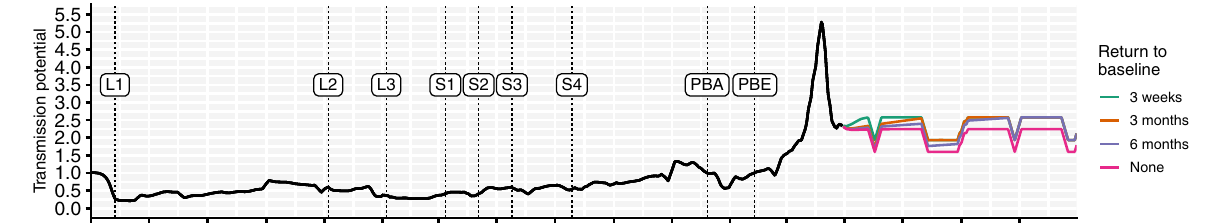
December2021andtheendingofthesemeasureson27thJanuary2022 67 .Middle: Fitted transmission adjustments between April 2020 and May 2022 by NHS England region (coloured lines) and the average across regions (black line), example projection between May and December 2022 for East of England (blue line) and mean (black line) and interquartile range (red shaded) for projected transmission adjustments betweenMay and December2022 acrossNHS England regions. Bottom: The overall transmission potential captures the combined impact of mobility and transmission adjustments on the time-varying potential for effective transmission, ignoring the impact of immunity and novel variants, though including the impact of school vacation periods. NE & Y North East & Yorkshire. NHS National Health